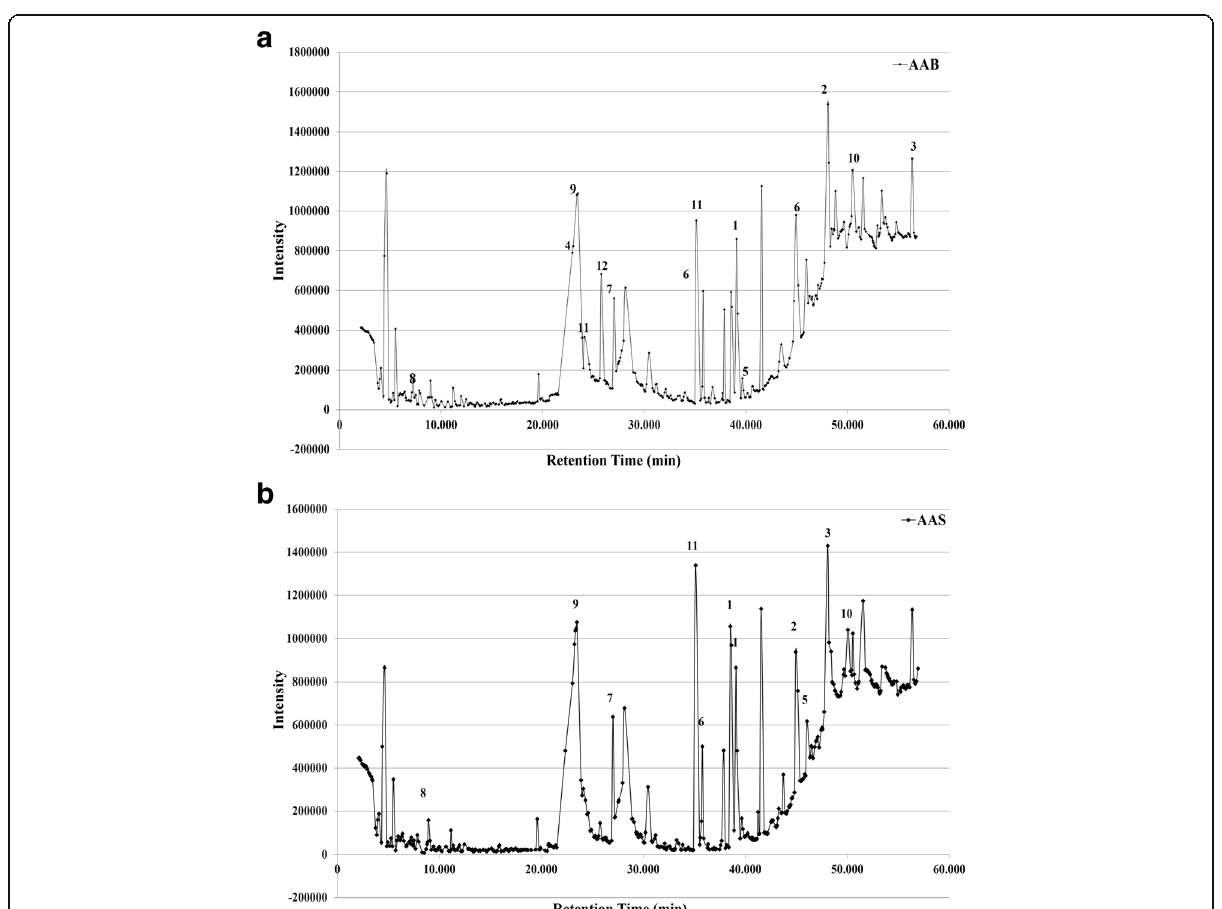
Fig. 7 GC-MS chromatogram of compounds from ethanol extract in ( a ) Allium autumnale bulb and ( b ) Allium autumnale stem. The numbered peaks correspond to the numbers and molecules in Table